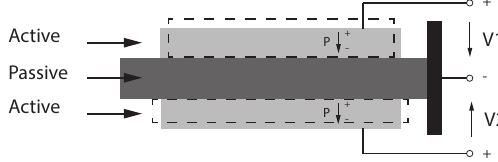
Figure 5. Bimorph